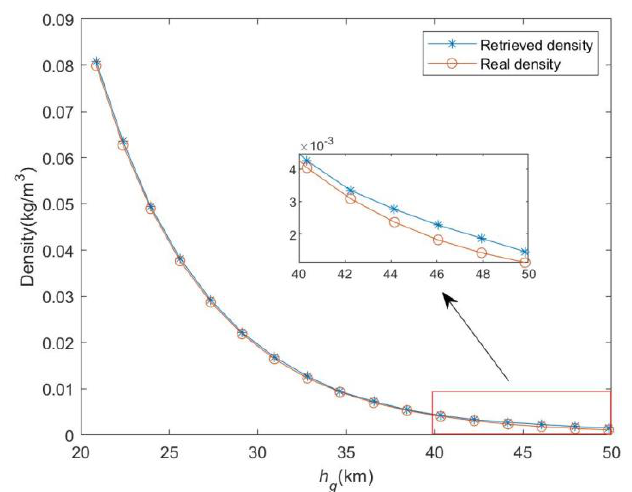
Figure 17. Retrieved density with the tangent height in one simulation.